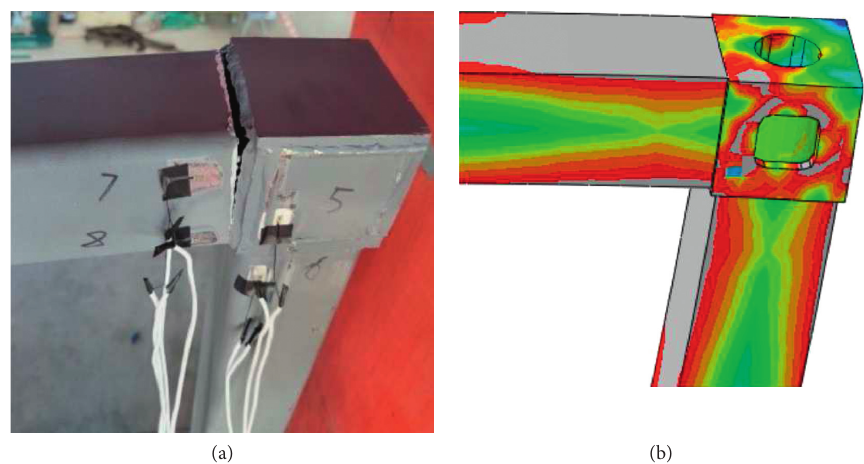
Figure 14: Comparison of failure mode for QKX-1. (a) Experimental results for QKX-1. (b) Calculation results for